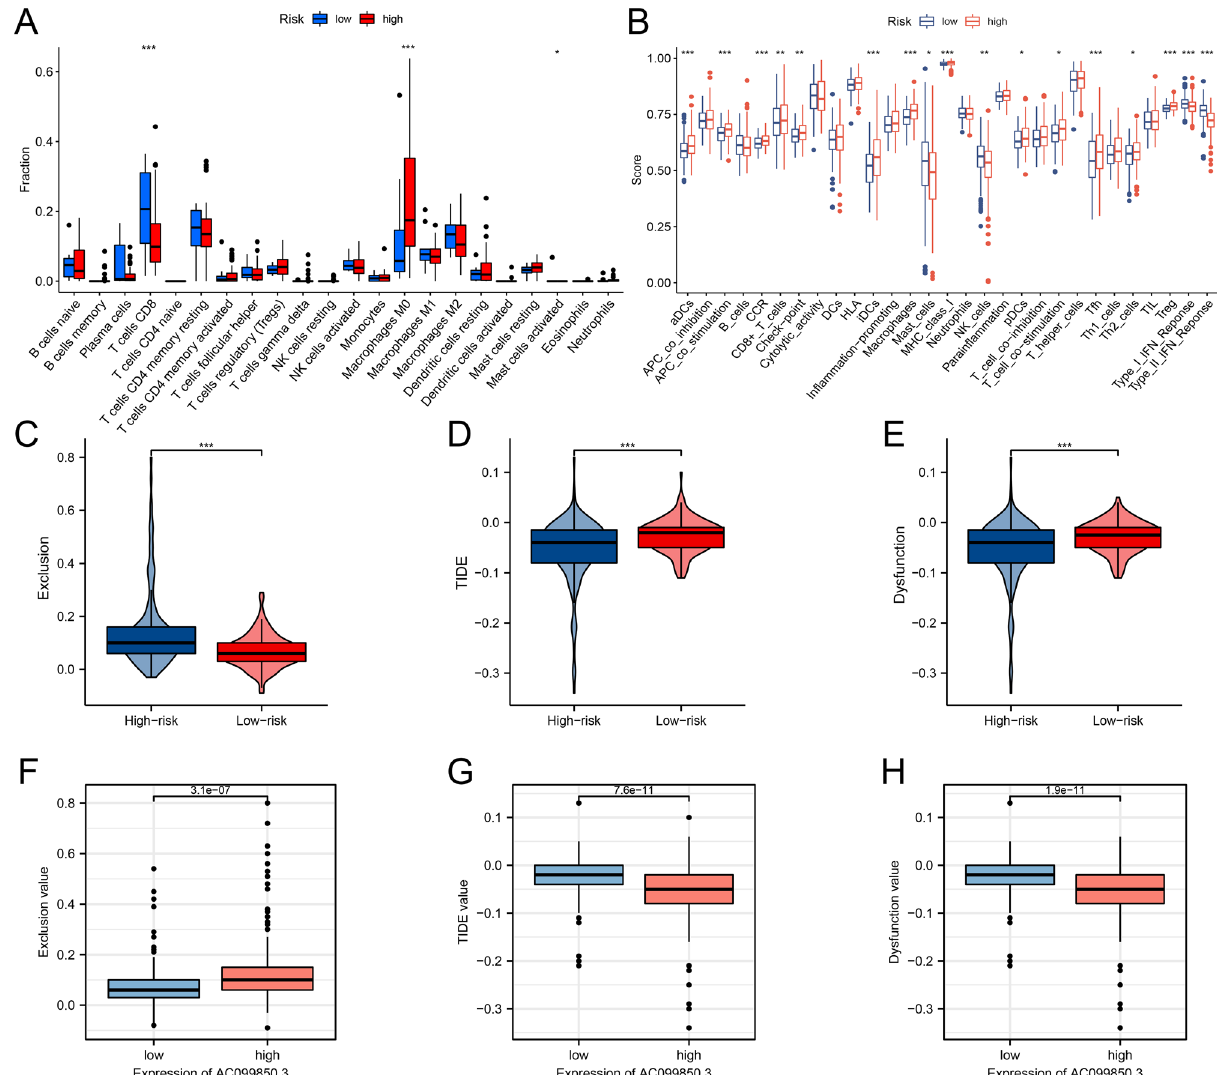
Figure 4. Patients with high- and low-risk scores had different immune status. Comparisons of ssGSEA scores for 22 immune celltypes (A) and 29 immune-related pathways (B) between low- and high-risk groups. (C) High immune exclusion score values in the high-risk group. Comparisons of TIDE (D) and immune dysfunction (E) scores for chemotherapeutics and targeted therapy between the two risk groups. Patients with high-risk scores were more suitable for immunotherapy. (F–H) TIDE analysis showing that patients with low AC099850.3 expressions had a low exclusion value as well as higher TIDE and dysfunction